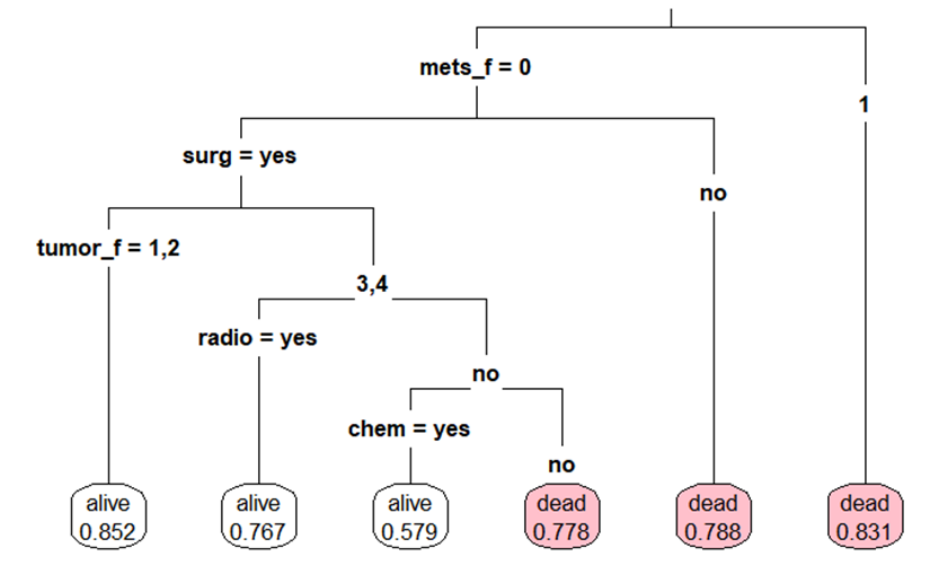
Figure 2. Decision tree classification analysis to predict death at five-year time point among patients with breast cancer ( n = 704). The leaf at the bottom of the tree refers to the probability of outcomes. The white leaf showed the probability of being alive, whereas the pink leaf showed the probability of being dead.